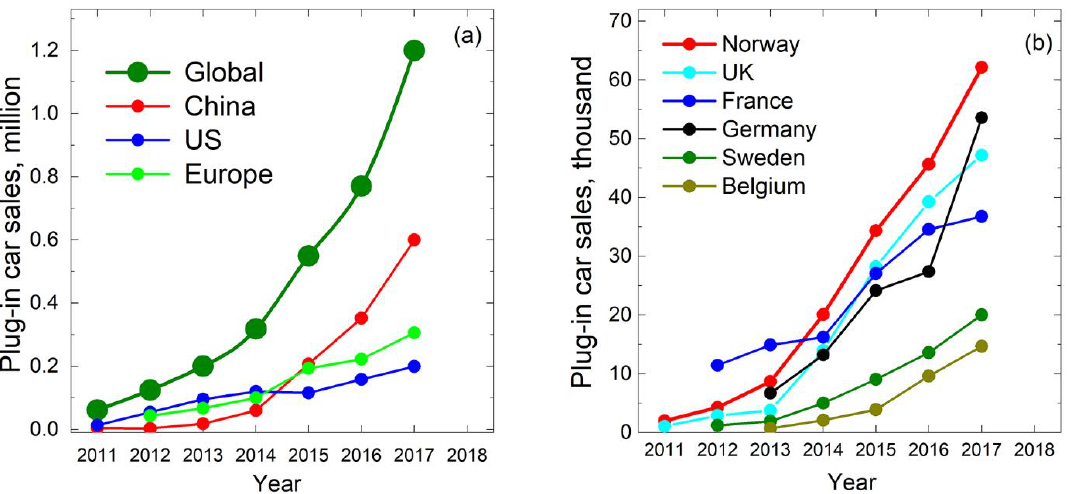
Figure 1. Annual plug-in car sales evolution: ( a ) worldwide, China, the United States, and Europe with ( b ) the specification for major European plug-in car markets.